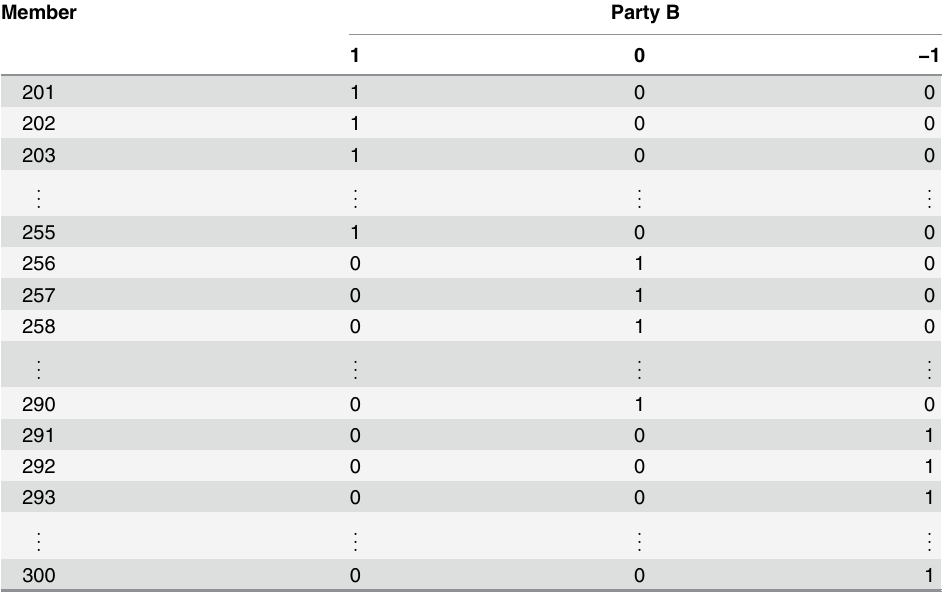
Table 4. A decomposition of Table 2 into multi-tables of Boolean-valued for Party